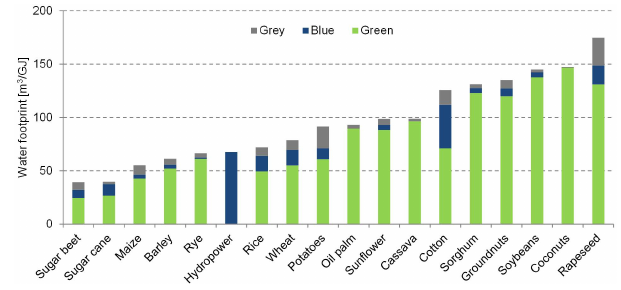
Fig. 3. Global average water footprint of electricity from hy- dropower compared to the water footprint of electricity from com- bustion of primary